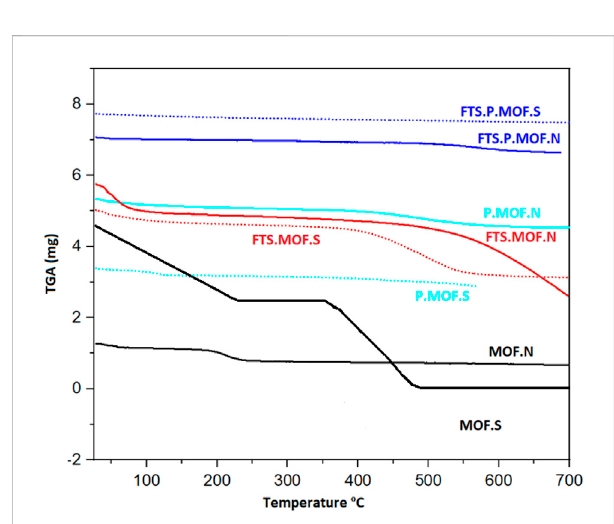
FIGURE 6 TGA analysis of ferric nitrate and ferric sulfate prepared MOF, pyrolysis MOFs and FTS